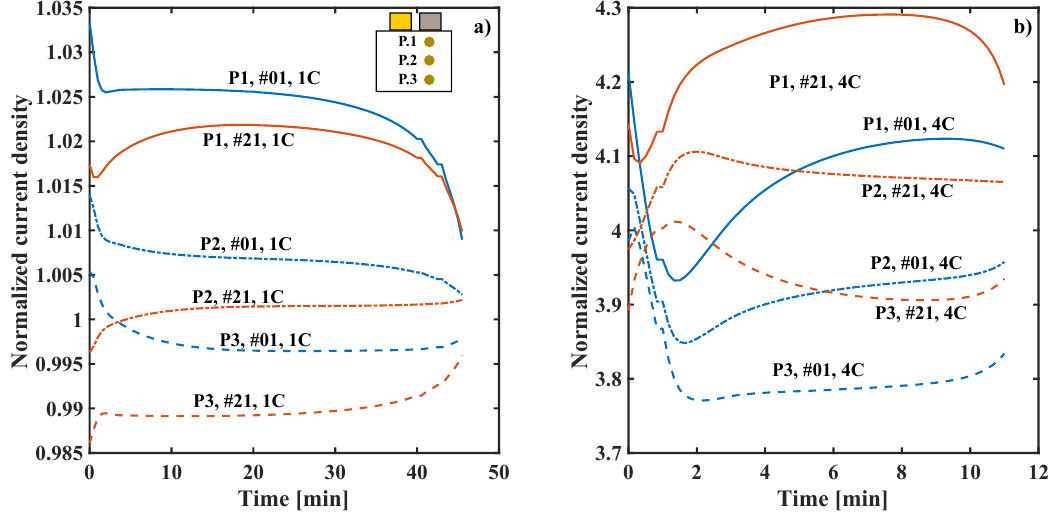
Figure 9. Evolution of local current density ( A/m 2 ) on various positions P i in different layers (#1, #21): ( a ) at 1C discharge; ( b ) at 4C discharge, where the local current density at the copper current collector is normalized by the nominal current density i x , nom = 25.25 A/m 2